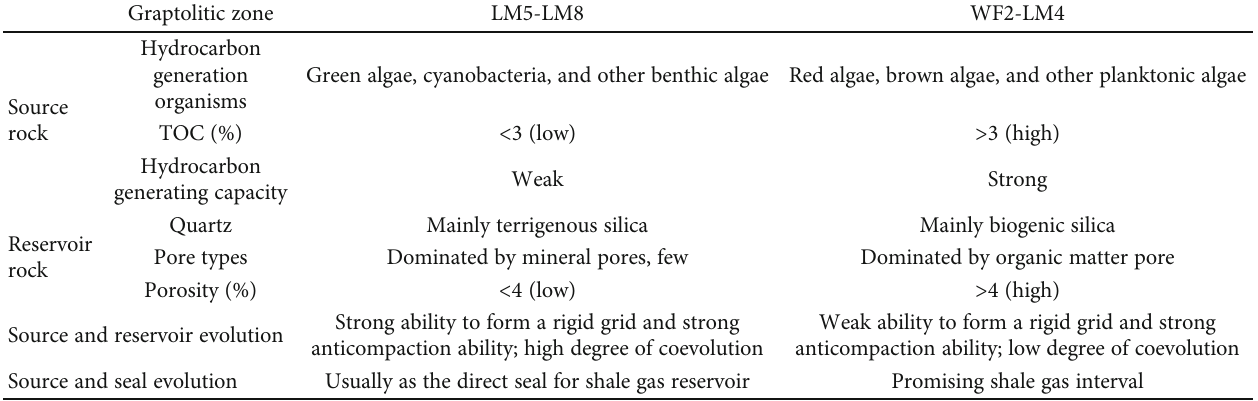
Table 1: Comparison of coevolutionary characteristics of between WF2-LM4 GZ and LM5-LM8 GZ in Wufeng Formation to the lower part of the fi rst member of Longmaxi Formation, Sichuan